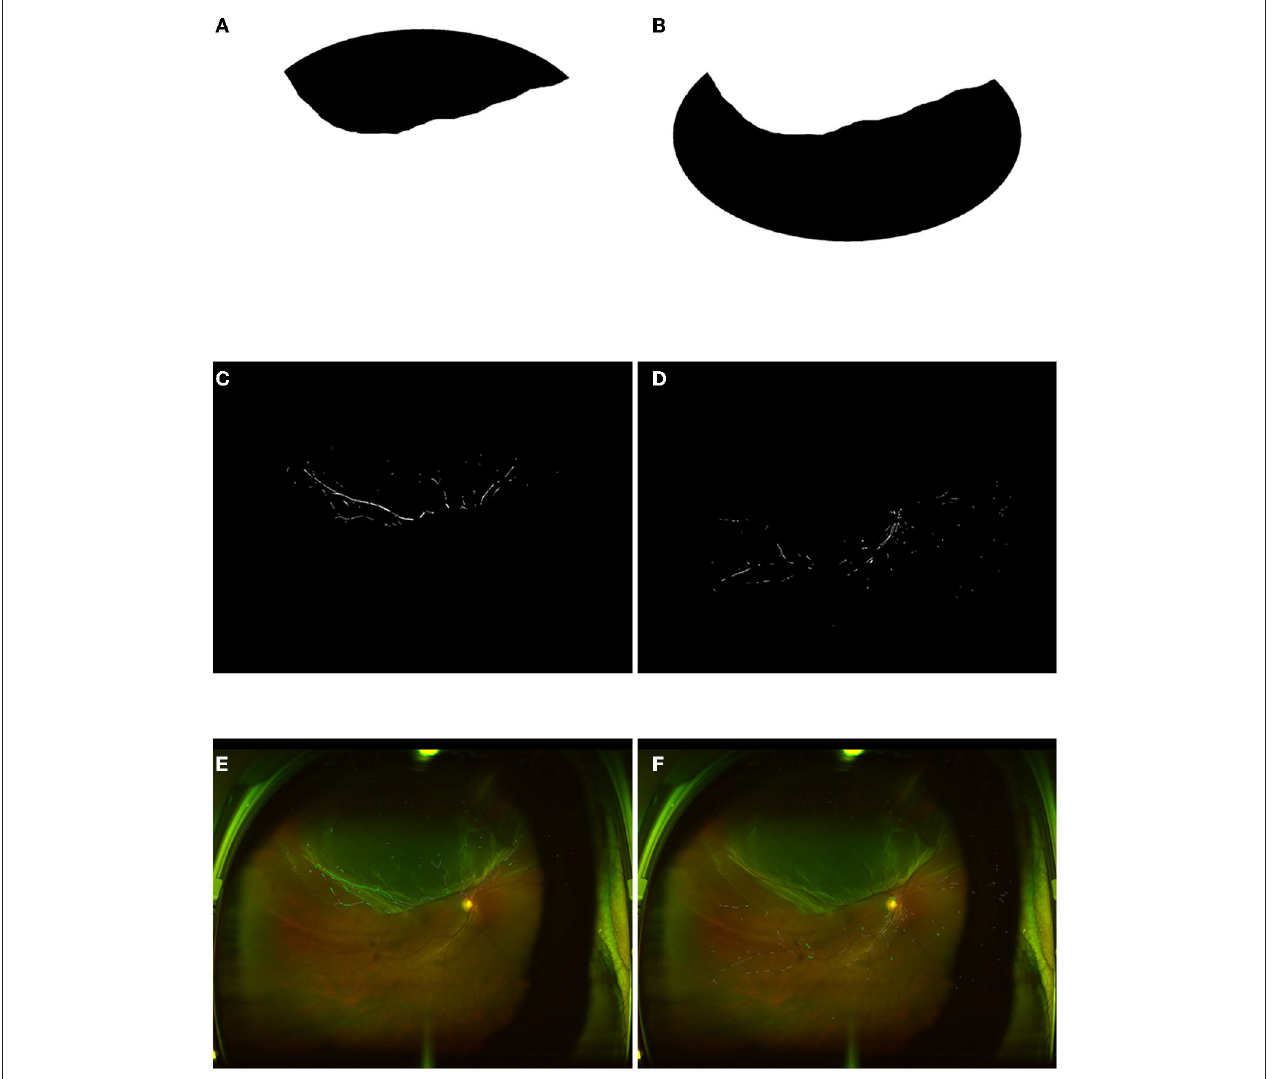
FIGURE 2 | Image process of RRD and non-RRD group with personality cover. (A) Personality cover for RRD part from one retinal image. (B) Personality cover for a non-RRD part from the same retinal image. (C,D) Extracted vessels as a binary image to compute vessel density from RRD and non-RRD parts. (E,F) The calculation for vessel caliber and tortuosity from RRD and non-RRD parts. RRD, rhegmatogenous retinal